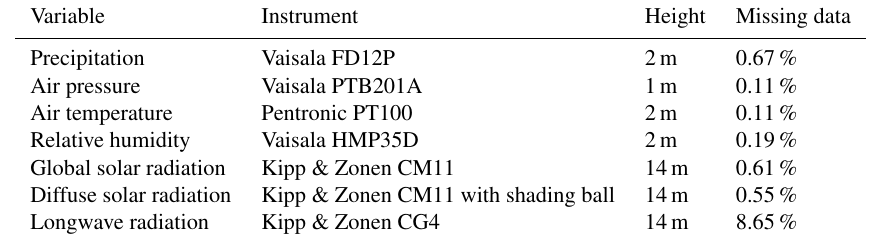
Table 1. Instruments and missing data for meteorological driving variables between 1 October 2007 and 30 September 2014.